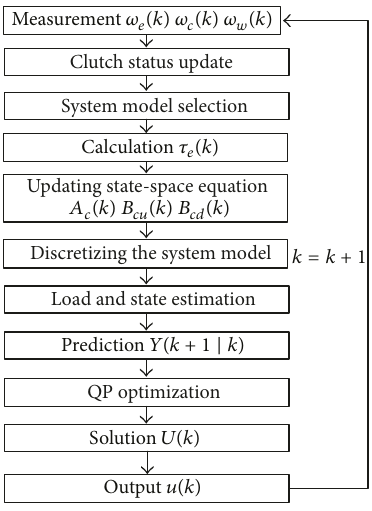
Figure 6: mMPC clutch controller